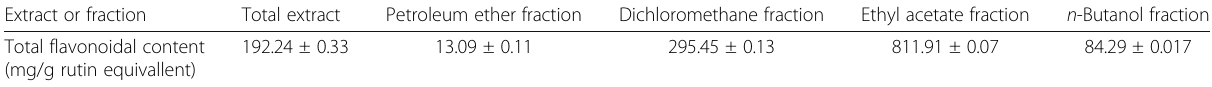
Table 2 Results representing the total flavonoid content of the total ethanol extract and the different fractions of C. myxa L. leaves Extract or fraction Total extract Petroleum ether